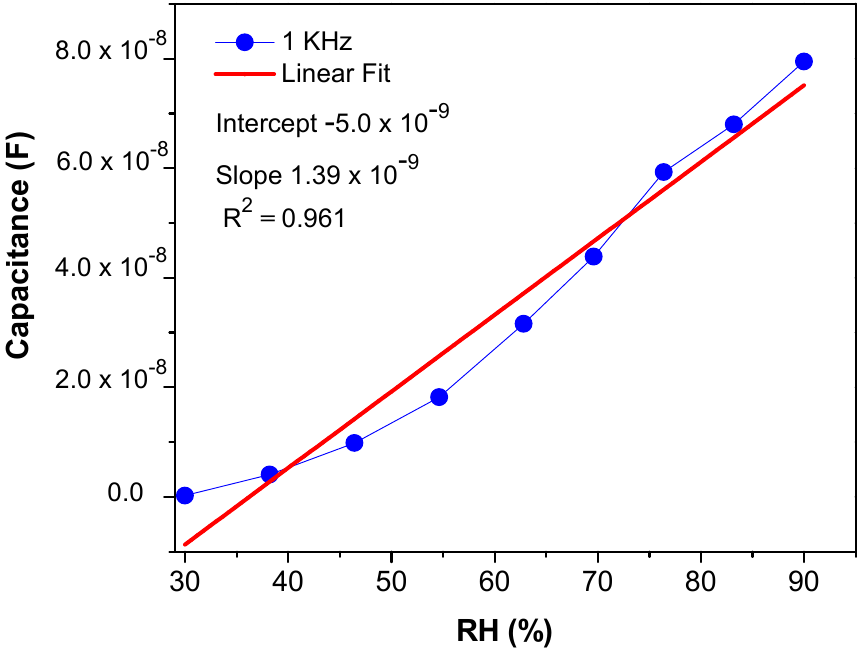
Figure 8. Capacitive linearity of PEO − MWCNT − CuO: 3% nanocomposites.